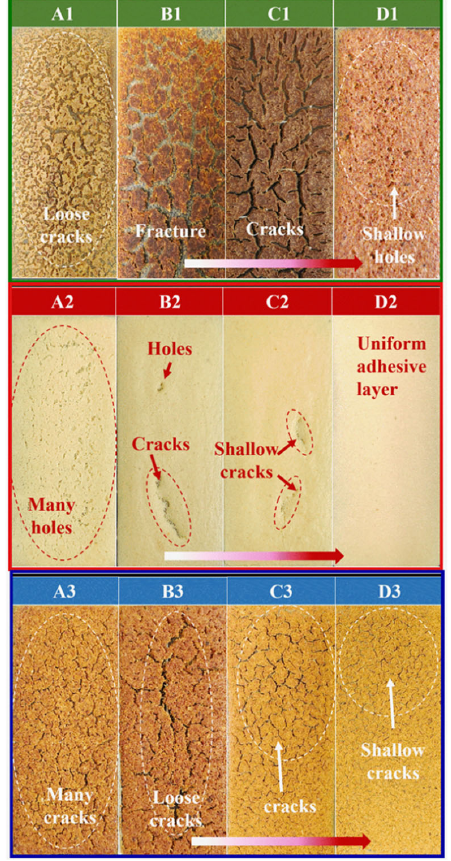
Figure 11. Cracks on the surface of A1 ‐ pure HPMP, B1 ‐ SDS/HPMP, C1 ‐ SDS/nSiO 2 /HPMP, D1 ‐ HPMP, A2 ‐ pure SBMP, B2 ‐ SDS/SBMP, C2 ‐ SDS/nSiO 2 /SBMP, D2 ‐ SBMP, A3 ‐ pure CSMP, B3 ‐ A2-pure SBMP, B2-SDS/SBMP, C2-SDS/nSiO 2 /SBMP, D2-SBMP, A3-pure CSMP, B3-SDS/CSMP, C3- SDS/CSMP, C3 ‐ SDS/nSiO 2 /CSMP, and D3 ‐ CSMP adhesives. SDS/nSiO 2 /CSMP, and D3-CSMP